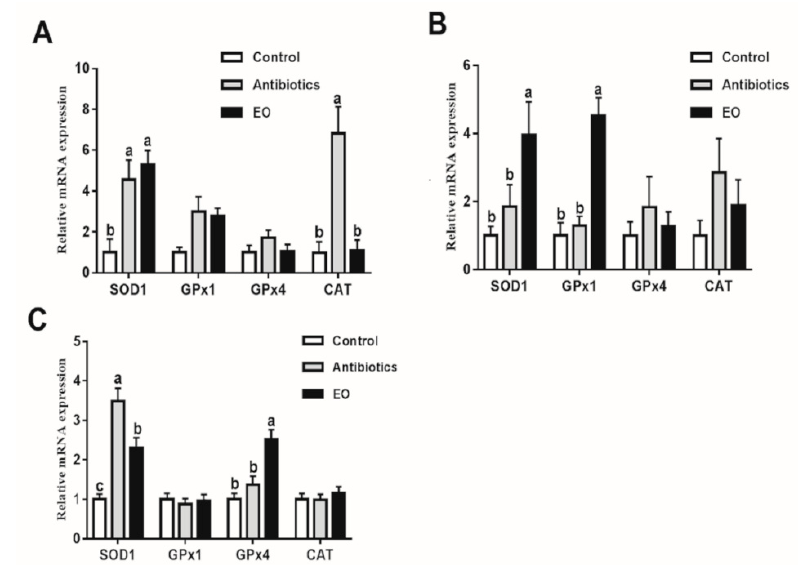
Figure 1. Effects of essential oil supplementation on antioxidant relative mRNA expression of jejunum ( A ) and ileum mucosa ( B ) and liver ( C ) in weaned pigs. Control = basal diets without antibiotics; Antibiotics = basal diets supplemented with 20 mg/kg colistin sulfate and 40 mg/kg zinc bacitracin; EO = basal diets supplemented with 100 mg/kg essential oil blend. The different superscripts within a gene indicate a significant difference ( p ≤ 0.05). All results are presented as mean ± SEM ( n = 6). Table 7. Effects of essential oil supplementation on antioxidant enzyme activity and oxidant products of intestine mucosa and liver in weaned piglets 1 .